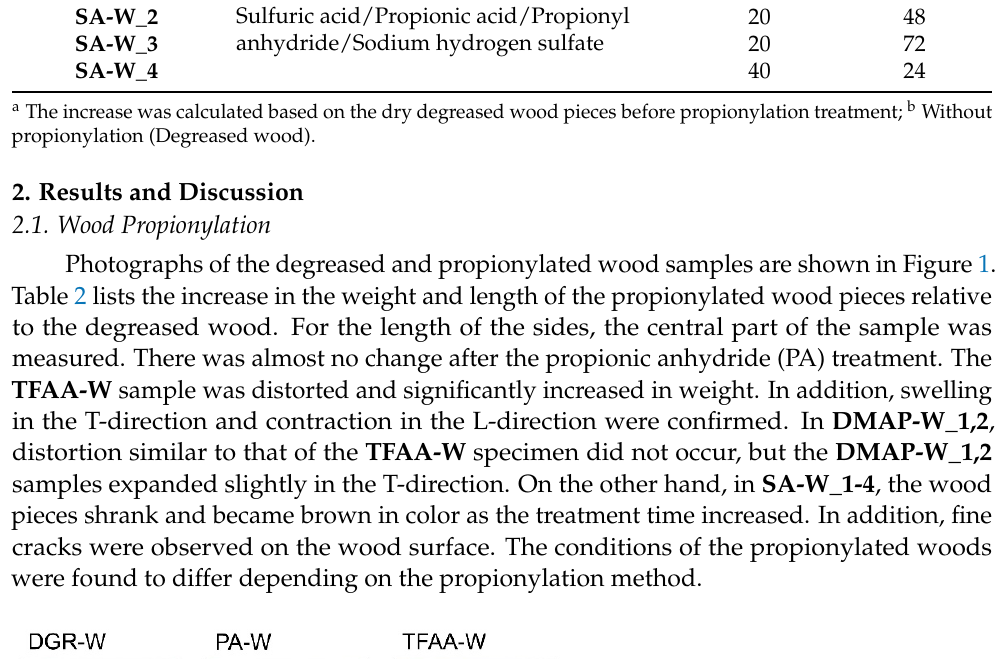
Table 1. Sample code of the synthesized woods and description of the propionylation methods.